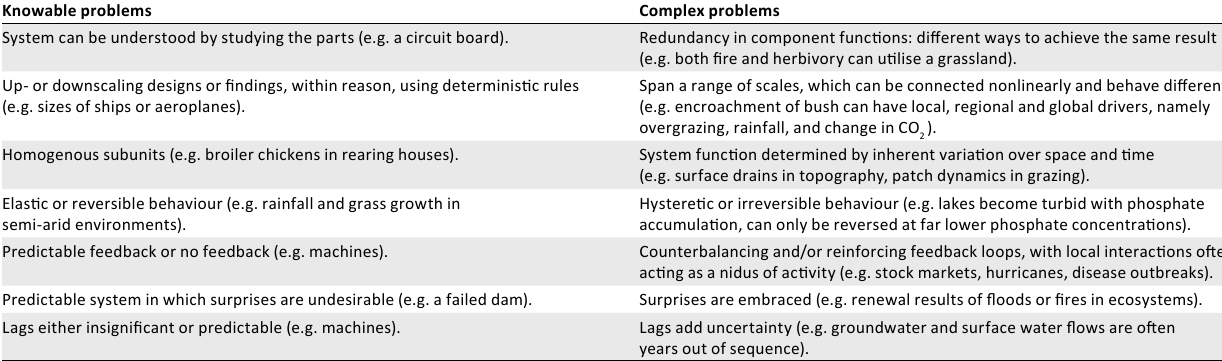
TABLE 1: Some characteristics of knowable and complex problems. Knowable